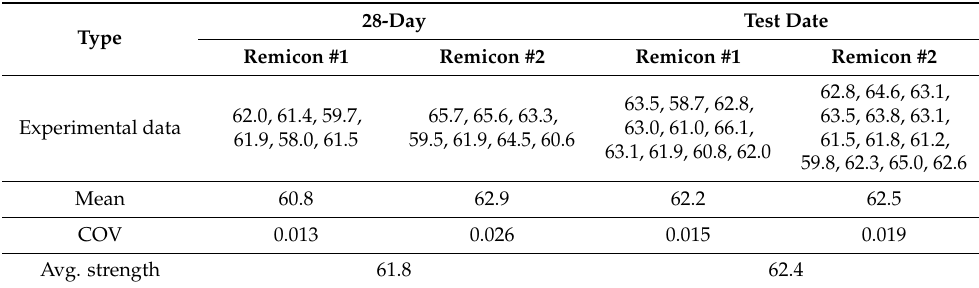
Table 2. Concrete compressive strength (unit: MPa).